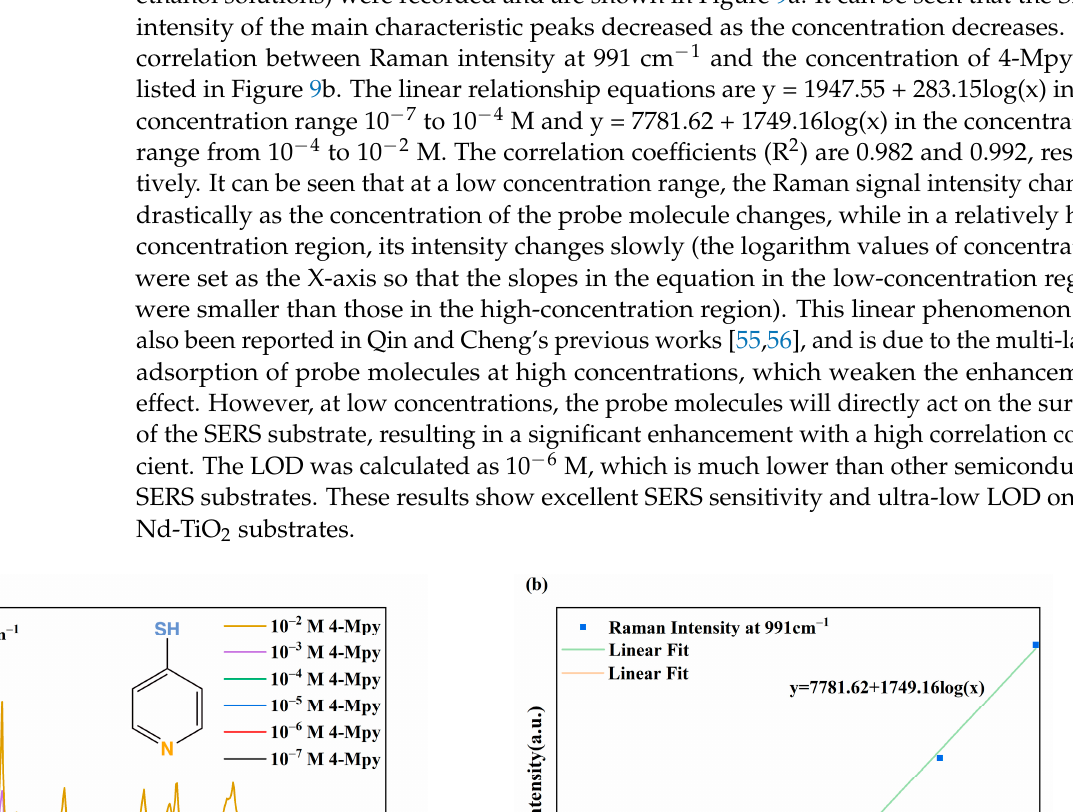
Figure 9. ( a ) SERS spectra of the 4-MPy on 2%Nd-TiO 2 NPs substrates with different concentrations from 10 − 2 to 10 − 7 M; ( b ) Raman intensity at 991 cm − 1 versus the concentration of 4-Mpy ranging from 10 − 2 to 10 − 7 M.